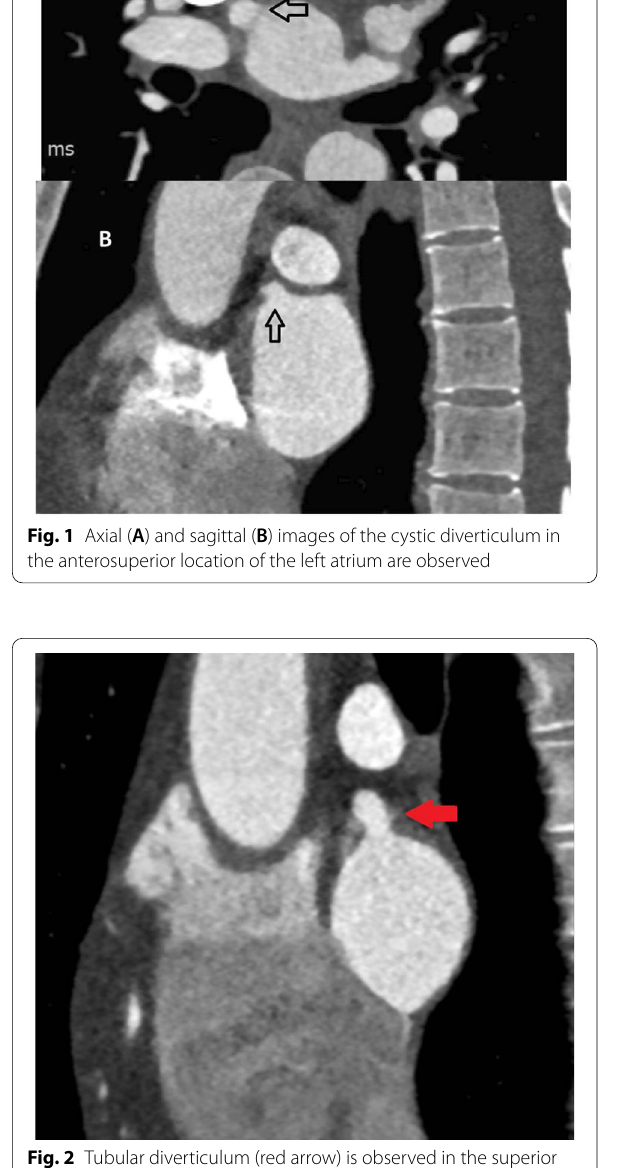
of acquired diverticulum. It is, therefore, more likely to have a congenital history. This study aimed to evaluate the prevalence, location, and size of left atrial accessory appendages and diverticulum in the Turkish population.